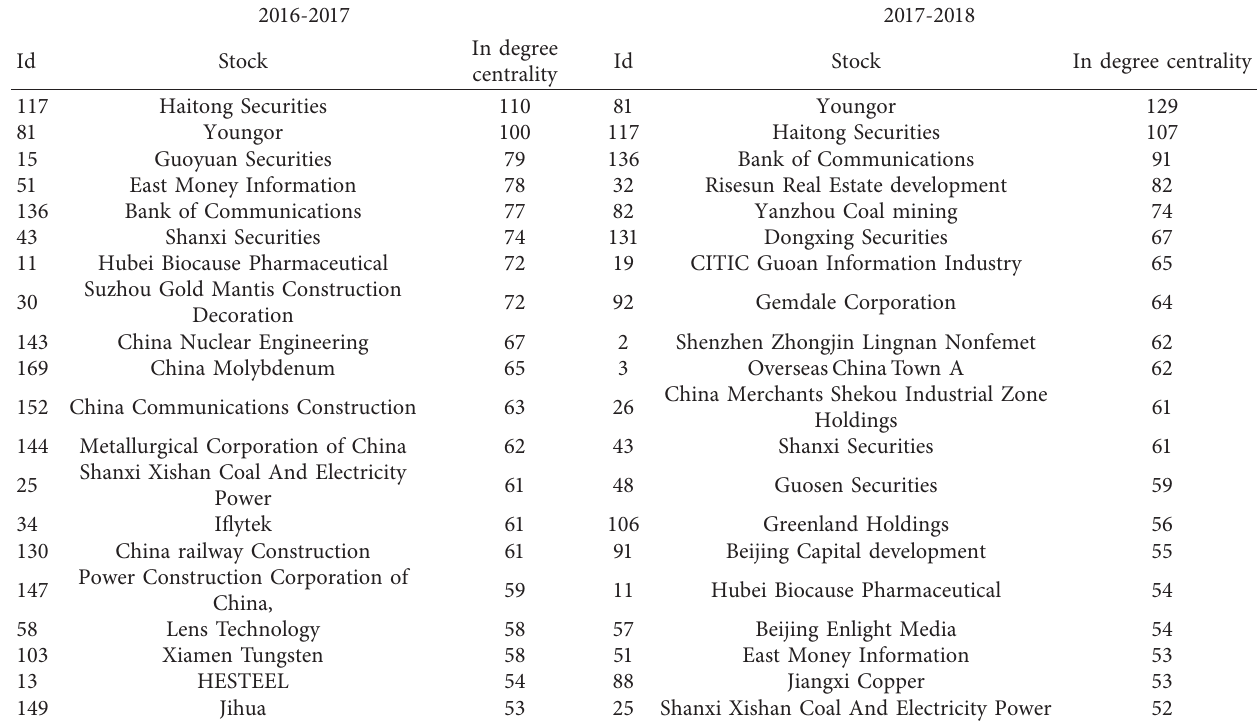
Table 6: Top 20 in degree centrality stocks of CSI 300 network during 2016-2017 and 2017-2018.